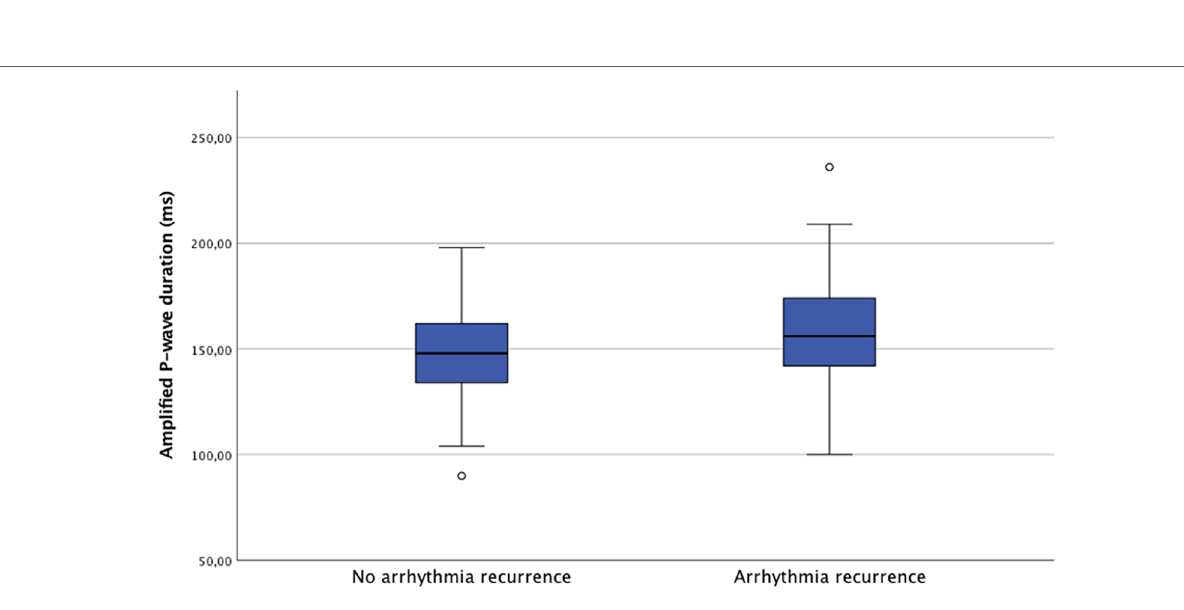
FIGURE 3 Distribution of APW duration strati fi ed by atrial arrhythmia